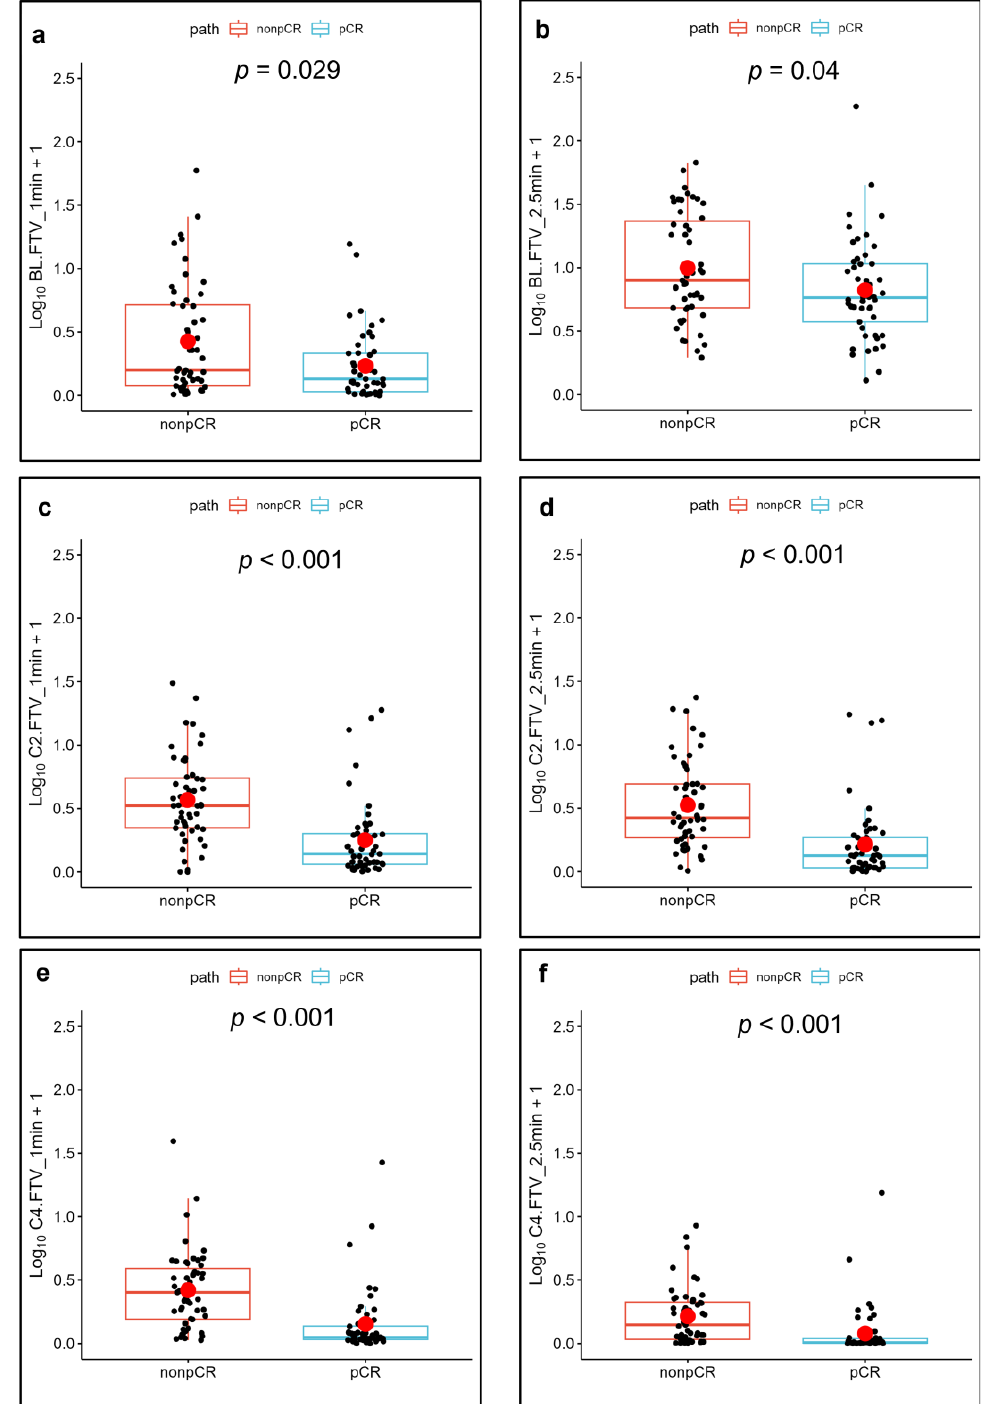
Figure 5. Functional tumor volume (FTV) plots and their mean (red circle) corresponding to optimal percentage enhancement (PE) and signal enhancement ratio (SER) for patients with pathologic complete response (pCR) and non-pCR. Plots correspond to images obtained ( a , b ) at baseline (BL), 1 min ( a ), and 2.5 min ( b ) after contrast agent injection; ( c , d ) after the second cycle of neoadjuvant systemic therapy (NAST) (C2), at 1 min ( c ), and 2.5 min ( d ) after contrast agent injection; and ( e , f ) after the fourth cycle of NAST (C4), at 1 min ( e ), and 2.5 min ( f ) after contrast agent